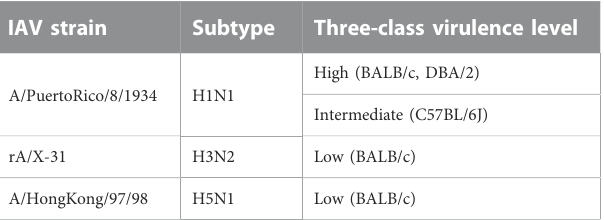
TABLE 5 IAV strains with DNA/RNA polymerases domain assigned to PB1 gene